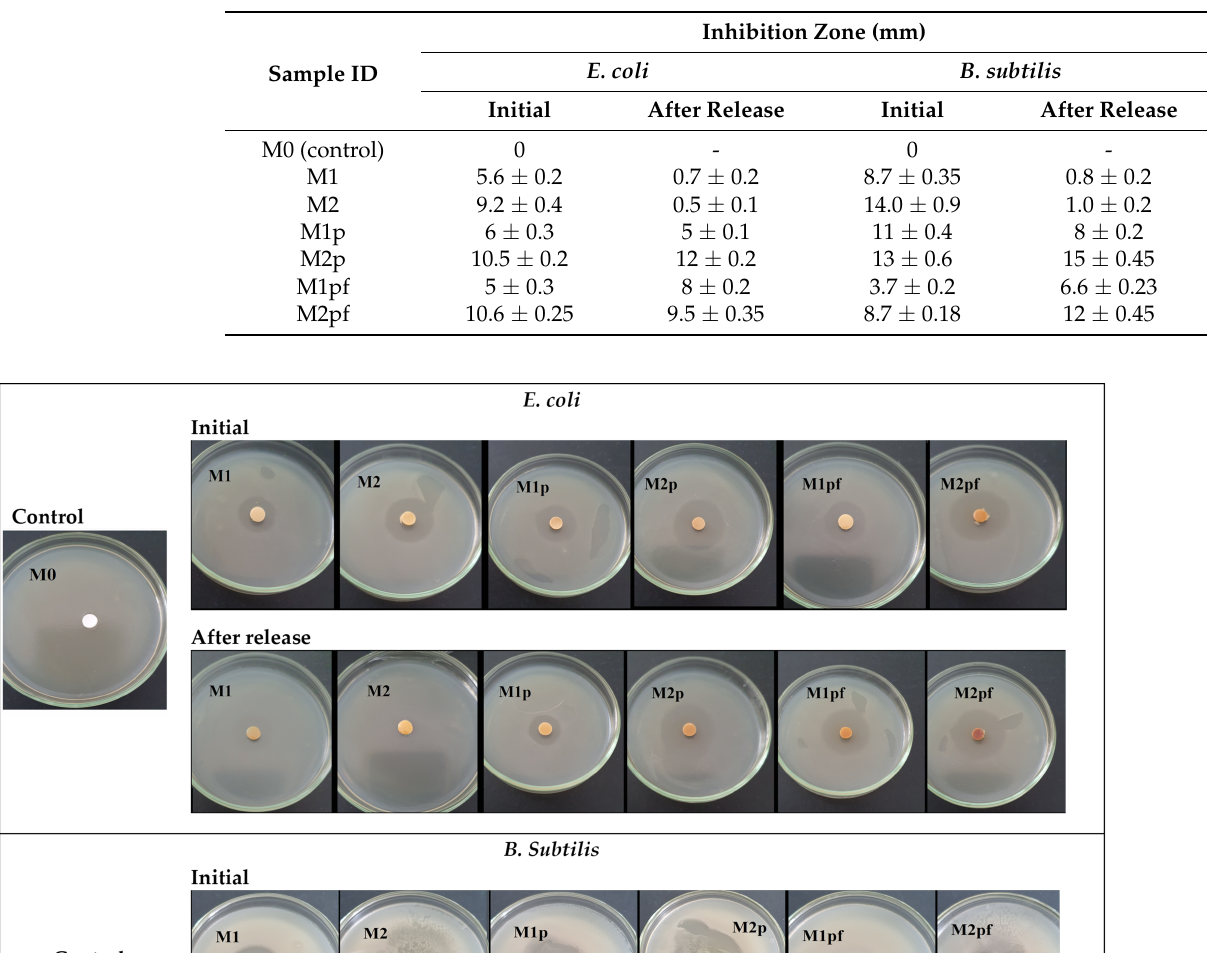
Table 3. Antibacterial activity of TC-HCl-loaded mono- and multilayer membranes.